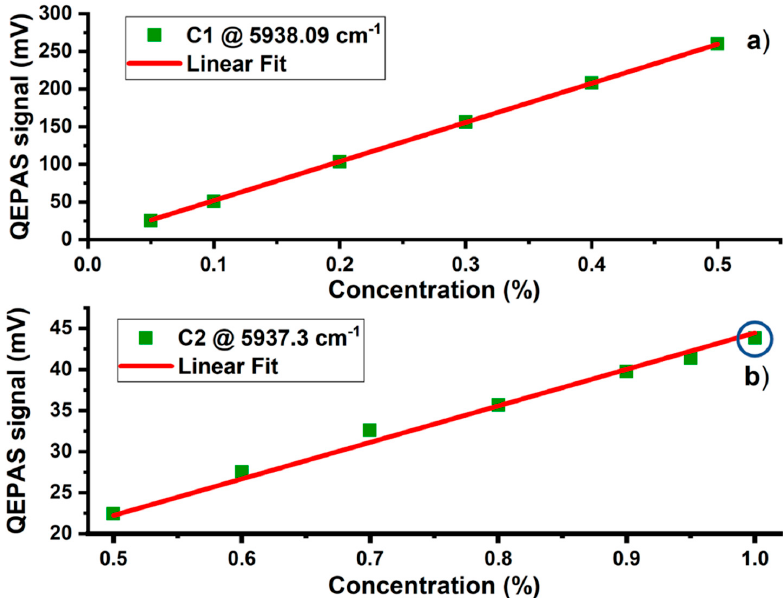
Figure 7. ( a ) Linearity of the 2f methane peak signal in the concentration range 0.05–0.5% in mixtures with C2 and N 2 . ( b ) Linearity of the 2f ethane peak signal in the concentration range 0.5–1% in mixtures with C1 and N 2 . The uncertainty of the measured data points lies within the size of the depicted data point symbols.